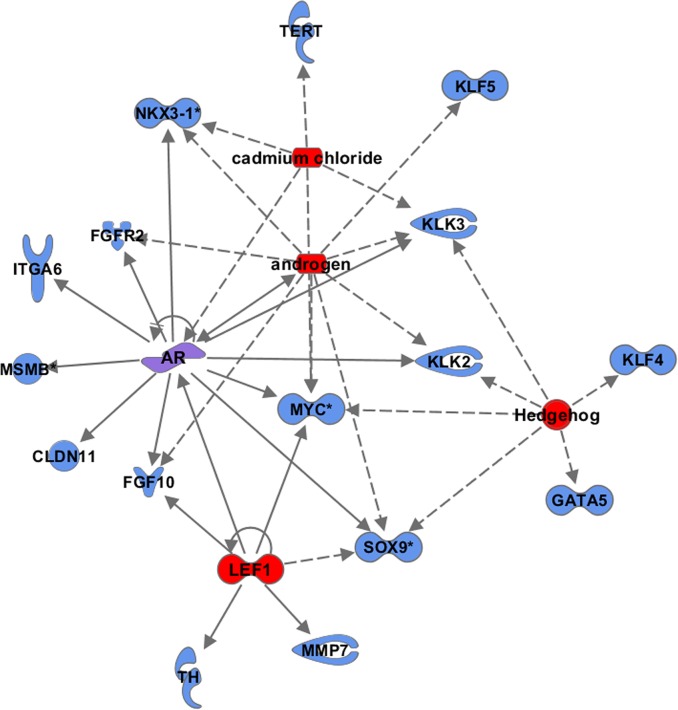
Upstream regulators among genes flanking prostate cancer risk alleles.The IPA Upstream Regulator tool was used to identify potential upstream regulators based on the statistical significance of genes in the gene list that function downstream of this regulator. The top 5 upstream regulators identified were androgen, androgen receptor (AR), lymphoid enhancer-binding factor 1 (LEF1), hedgehog (HH), and cadmium chloride. Upstream regulators (red); AR was both and upstream regulator and on the gene list (purple shading); genes from the gene list (blue).